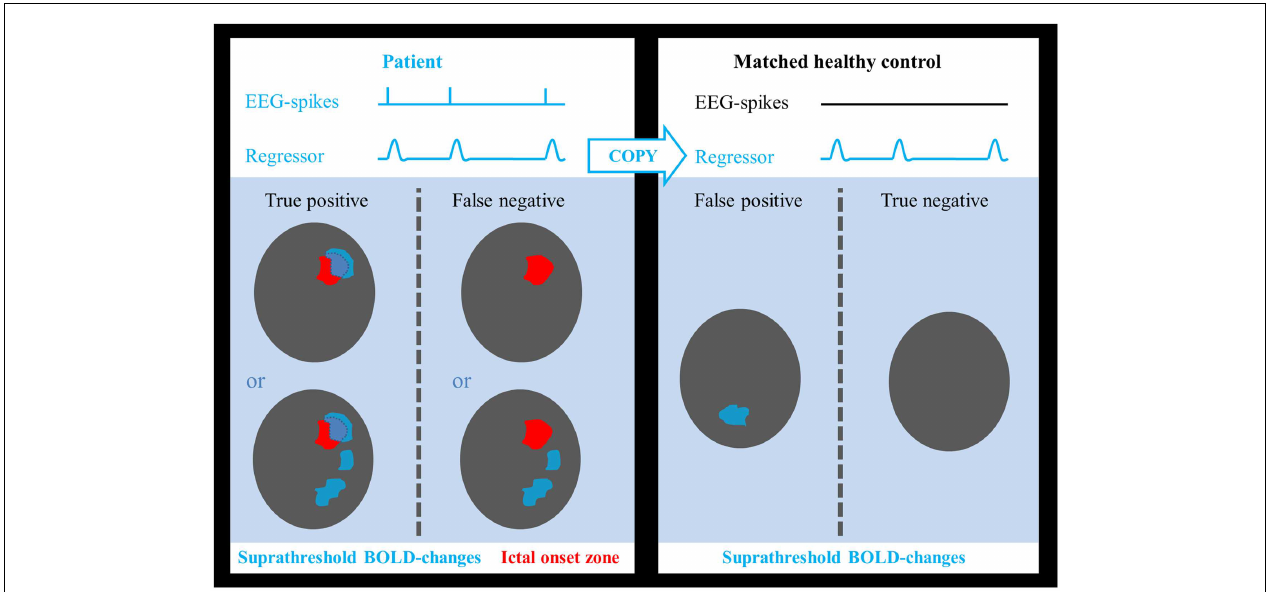
patients were considered as true positives and if no overlap was found, they were treated as false negatives. Suprathreshold BOLD changes in any part of the brain in healthy controls were considered as false positives, absence of BOLD responses as true